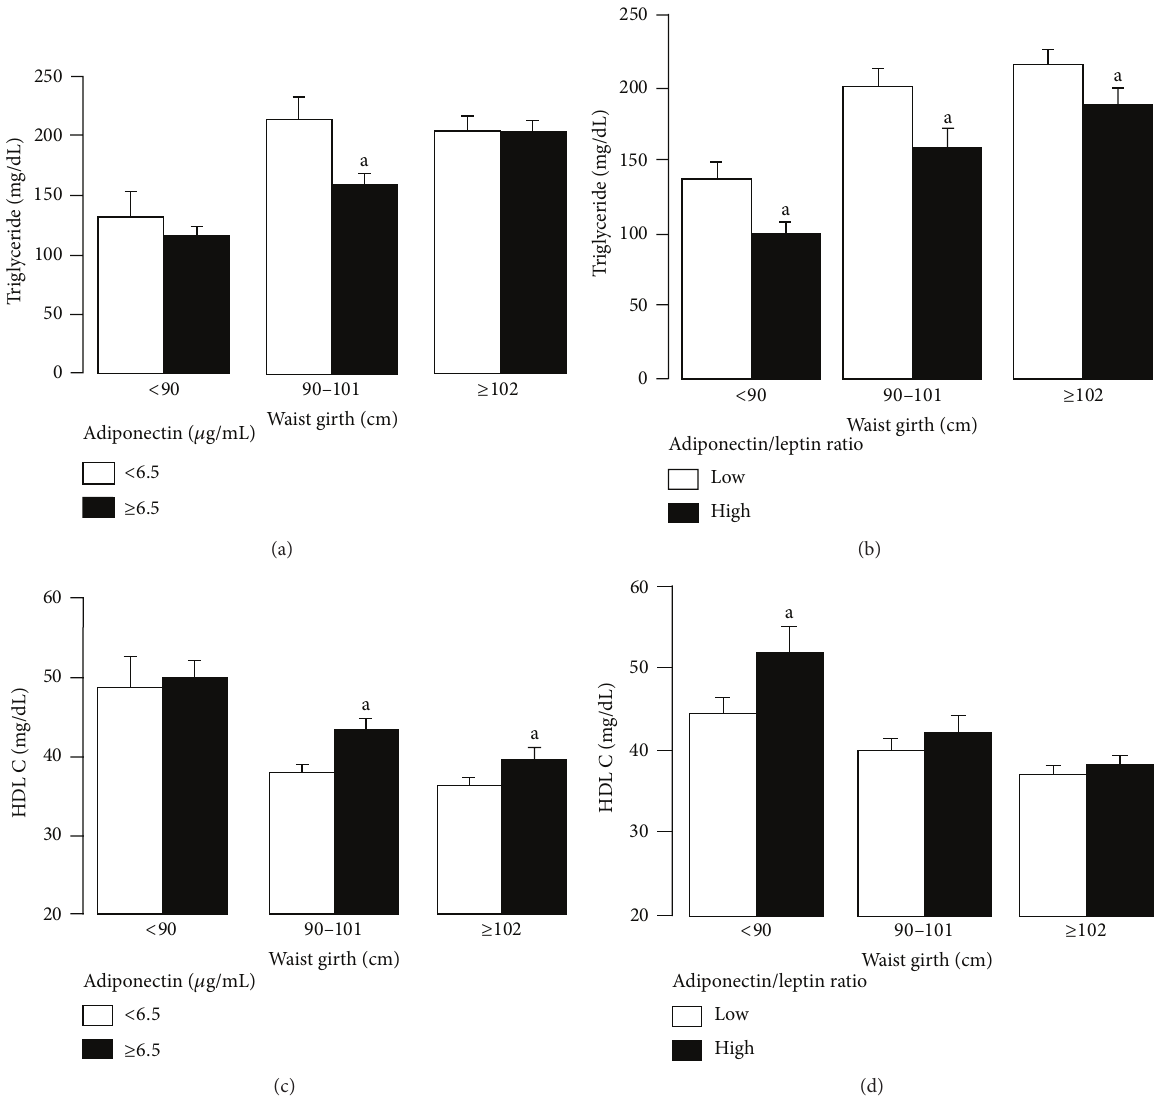
Figure 2: Levels of plasma triglyceride in nonobese (waist girth < 90cm), overweight (waist girth 90 to 101cm), and obese ( ≥ 102cm) grouped according to low ( < 6.5ng/mL) or high ( ≥ 6.5ng/mL) adiponectin. Overweight men with high adiponectin levels have significantly ( a 𝑃 < .02 ) lower levels of plasma triglyceride compared with those with low adiponectin levels (a). However, after adjustment of adiponectin levels for leptin (ratio of adiponectin/leptin), levels of plasma triglycerides were significantly ( a 𝑃 < .02 ) lower in those with a high ratio of adiponectin/leptin, regardless of waist category (nonobese, overweight, or obese) (b). Similar analyses are shown for HDL C. Levels of plasma HDL C were significantly ( a 𝑃 < .02 ) higher in overweight and obese men having a high adiponectin level (c). However, HDL cholesterol levels were significantly higher ( a 𝑃 < .02 ) in nonobese men after grouping the subjects according to a low or high ratio of adiponectin/leptin